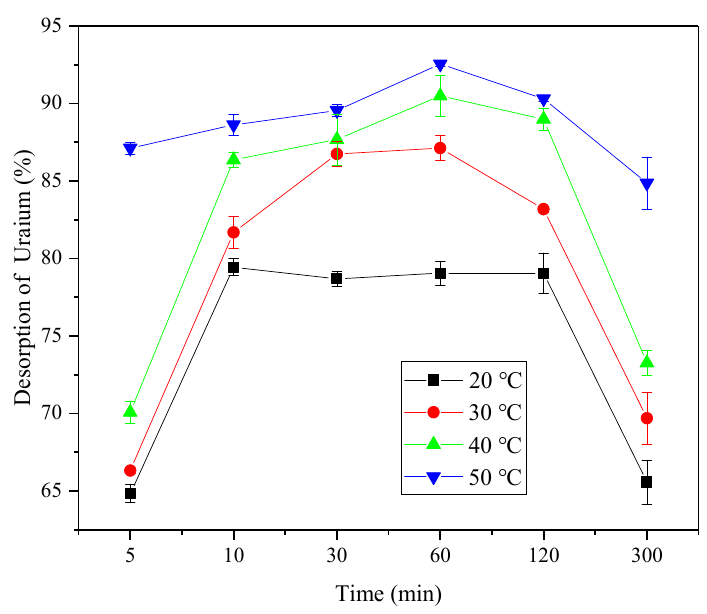
Figure 14. Desorption of Uranium at different temperatures.